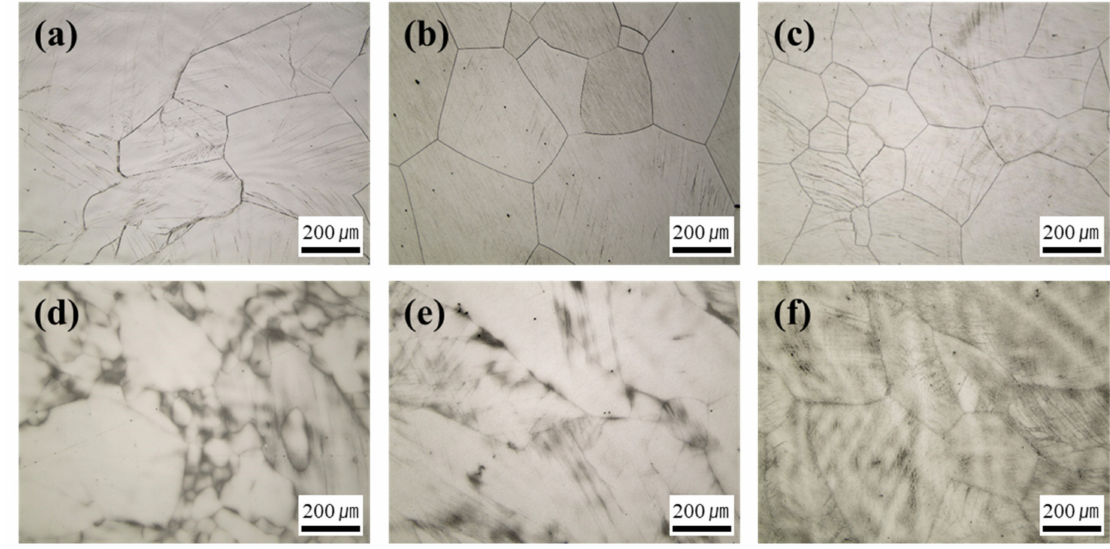
Figure 1. Optical microscopy of as-swaged specimens ( a – c ) and solution treatment and aging (STA)-treated ( d – f ); ( a , d ) TNZ40, ( b , e ) TNZ40 + 0.1 Si, and ( c , f ) TNZ40 + 0.2